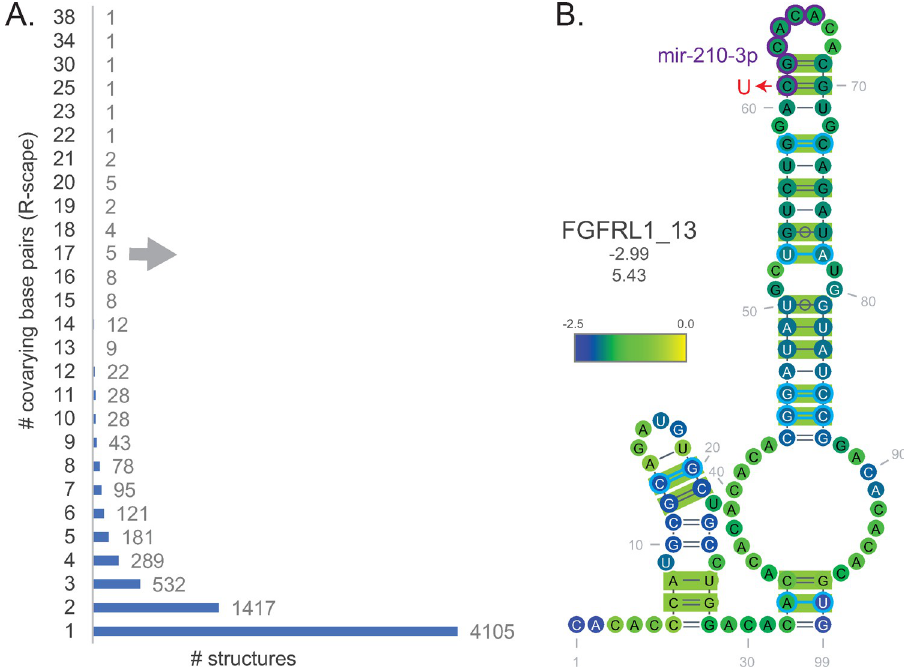
Fig 3. Covariation analysis and example. (A) Graph showing the number of structures per the number of covarying base pairs determined by R-scape covariation analysis of all structures. (B) Predicted secondary structure of Fibroblast growth factor receptor like 1 structure 13 ( FGFRL1 _13) shown as a middle of the road example with both R-scape (green boxes) and CaCoFold (cyan lines) covariation results. The TargetScan predicted miR-210-3p binding site and an identified COSMIC mutation are marked in purple and red, respectively. Per nucleotide z-score mean is shown as indicated. Values of the structure z-score (not the average of per nucleotide windows) and the Zcm are provided under the structure name,